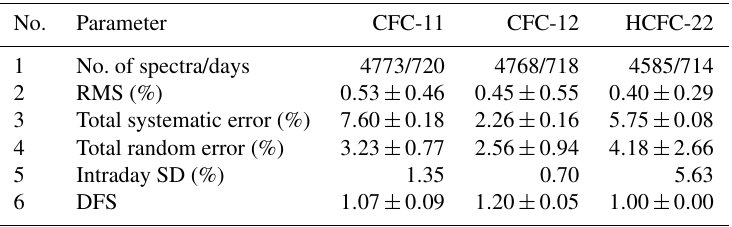
Table 2. Summary of the statistics for retrieved halocarbons TCs before filtering. The values after the “ ± ” sign indicate the standard deviation (SD). DFS is the number of degrees of freedom for signal.